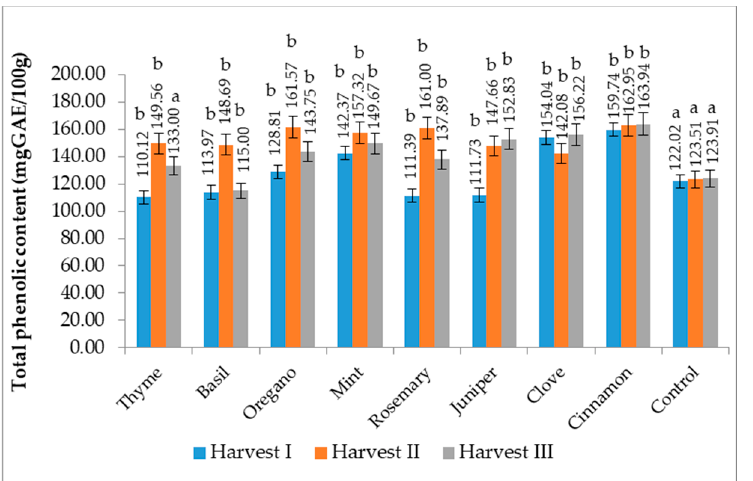
Figure 6. TPC of the samples before (Harvest I), after (Harvest II) the use of EOs in the supplementary food of bee families, respectively after the first harvest (rapeseed) (Harvest III). Different letters between control and samples indicate significant differences ( p < 0.05) among these values according to the t -test.